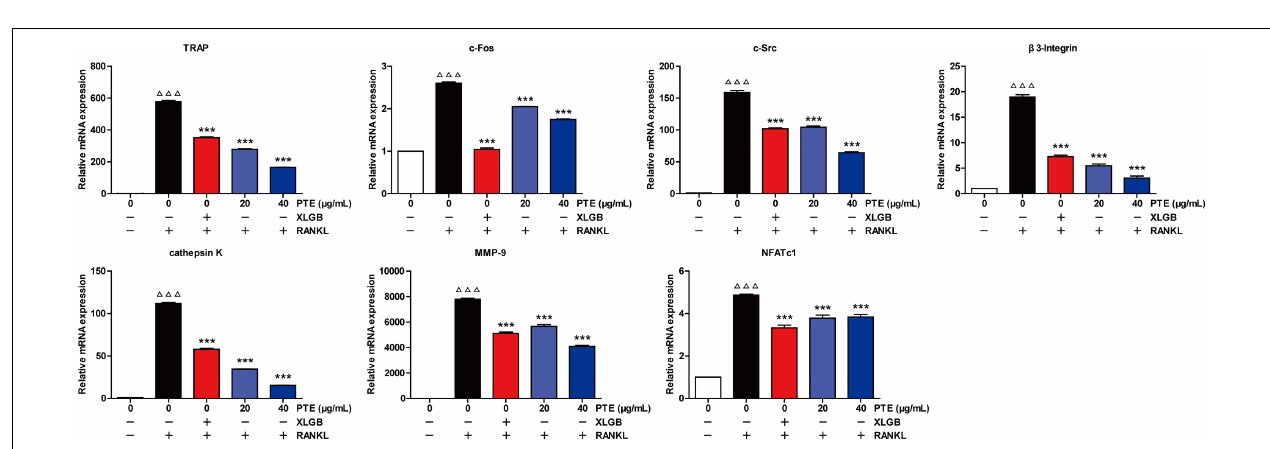
FIGURE 4 | Pu-erh tea extract inhibited osteoclast differentiation in the RAW264.7 cells. RAW264.7 cells were cultured for 6 days with RANKL (50 ng/mL) in the presence of Xian-Ling-Gu-Bao (XLGB) (10 µ g/mL) or the indicated concentrations of PTE and then stained for TRAP (A) . TRAP-positive multinucleated cells with more than five nuclei were considered mature osteoclasts, as observed under a light microscope (B) . The effect of PTE on the viability of RAW264.7 cells as determined by the MTT assay (C) . Representative images were acquired under a light microscope (magnification × 200). Values are shown as the mean ± SEM of three independent experiments. (cid:77)(cid:77)(cid:77) P < 0.001 versus the control; and ∗ P < 0.05 and ∗∗ P < 0.01 versus only RANKL-treated cells.